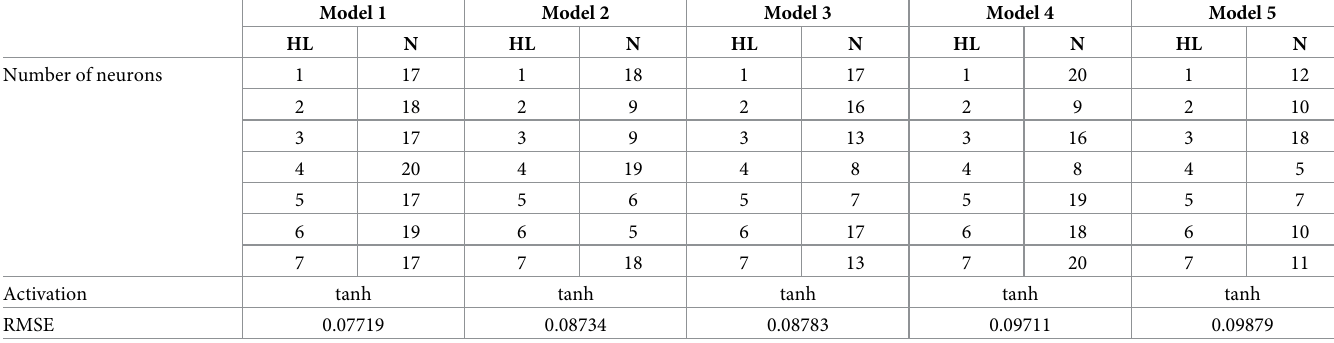
Table 14. Hyperparameter search results summary (Run 7). Top 5 Models out of 250 candidate models from Run 7. Model 1 Number of